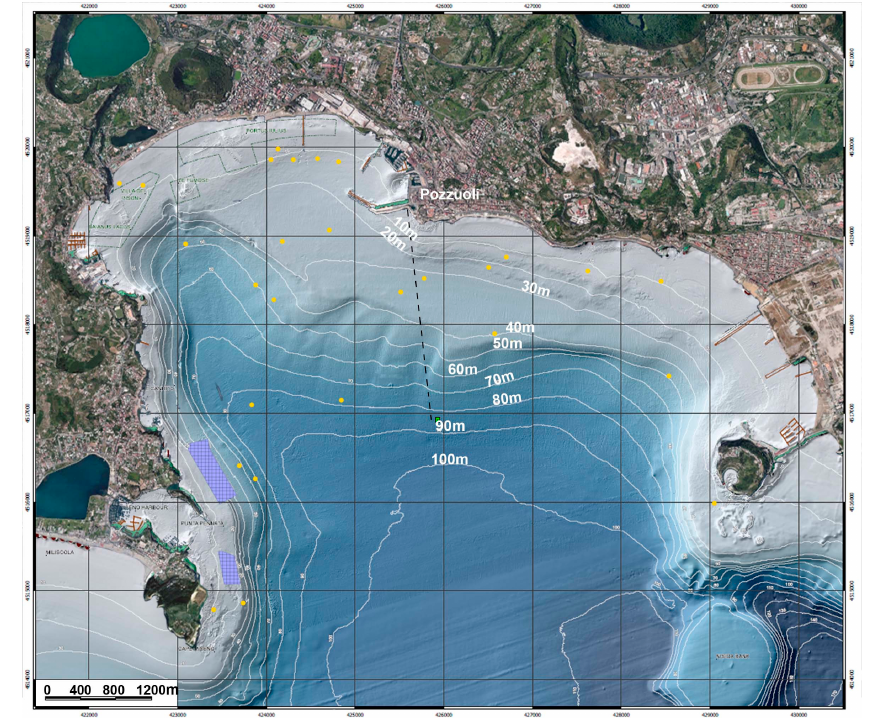
Figure 3. High resolution morpho-bathymetry of Pozzuoli Bay (modified after [37]). The dotted line is the trace of the optical fiber cable. Yellow circles are the fluid emissions inferred from the high-resolution survey.